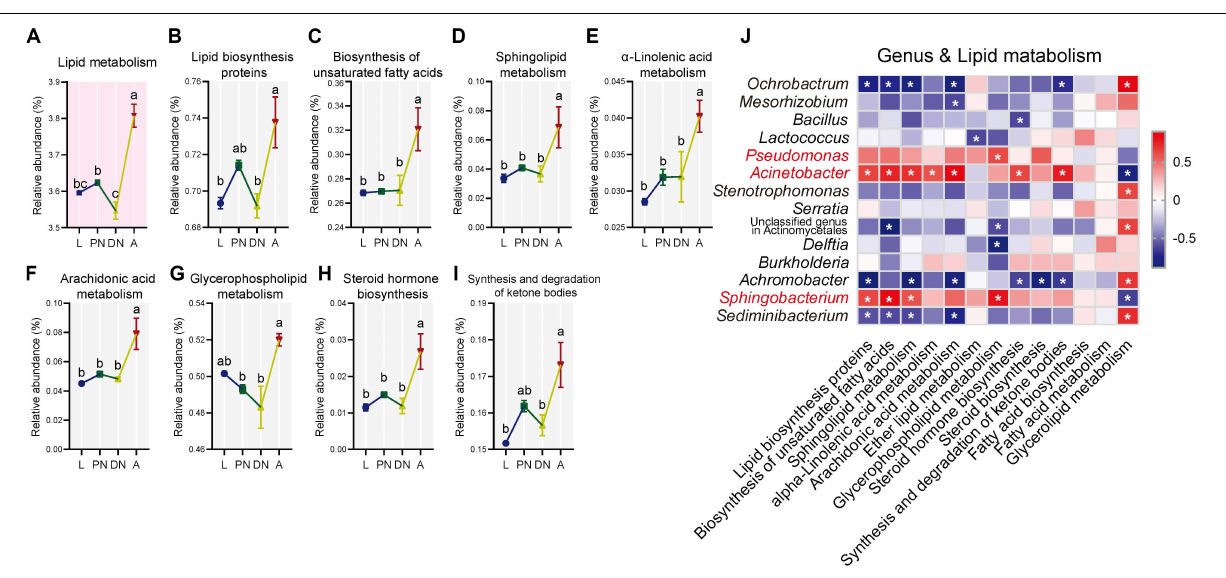
FIGURE 5 | Dynamics of predicted KEGG pathways of “lipid metabolism” and sublevel pathways across the lifespan of P. citri . (A–I) The “lipid metabolism” pathway at level two (A) and eight sublevel pathways at level three (B–I) significantly varied across the larva (L), protonymph (PN), deutonymph (DN), and adult (A) stages; all n = 3; different lowercase letters denote significant differences between different life stages ( P < 0.05, post hoc DMRT); plots showed means ± SEM. (J) Heatmaps based on Spearman’s correlation analysis between the relative abundances of “lipid metabolism” pathways and major genera; the red and blue represent positive and negative correlations between the relative abundances of pathways and bacterial genera, respectively; *indicated P < 0.05, Spearman’s